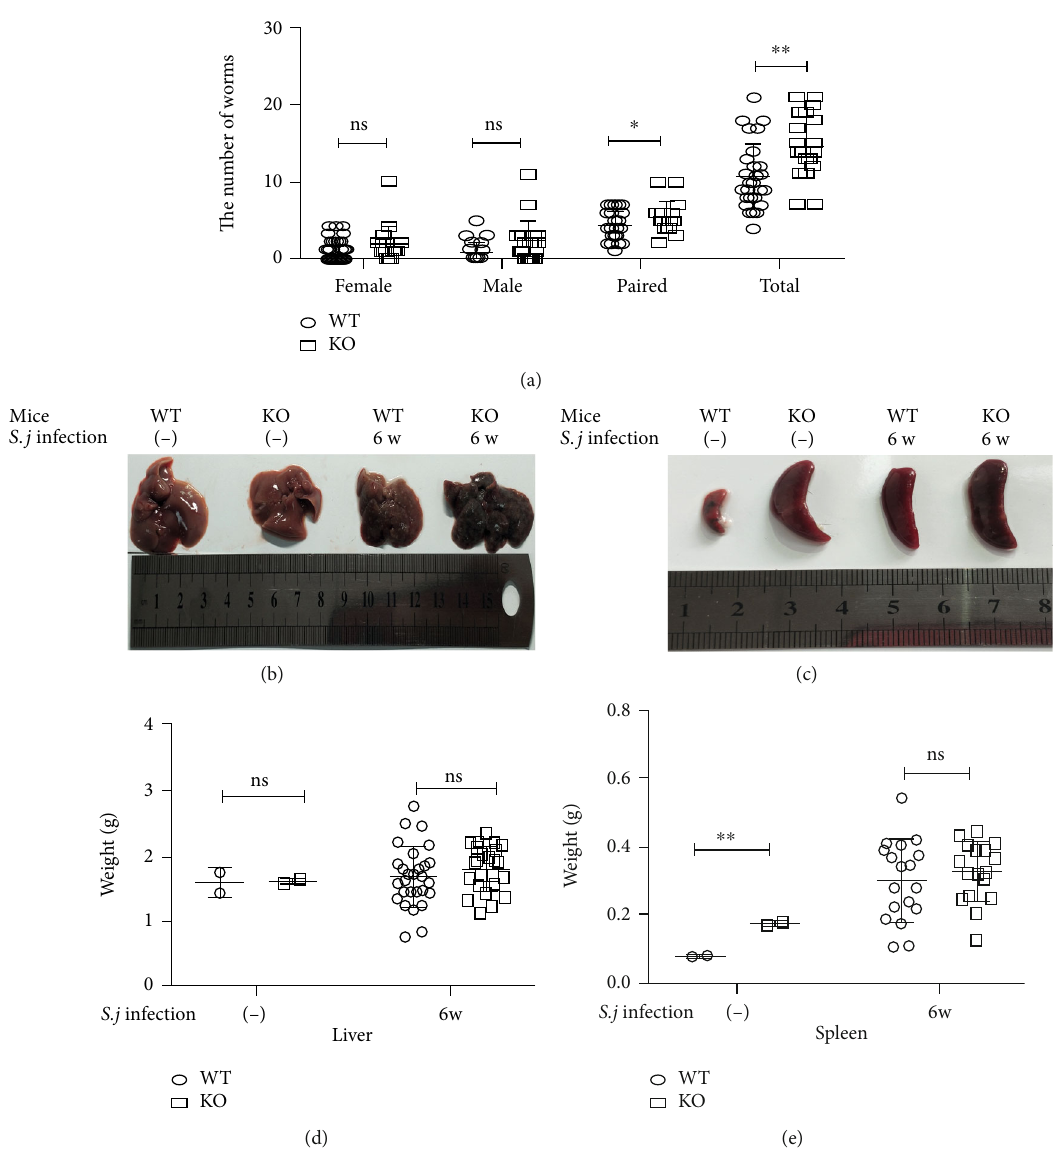
Figure 1: Deletion of USP21 in Tregs reduces the resistance to S. japonicum in infected mice. (a – e) FOXP3 Cre (WT) and USP21 fl / fl FOXP3 Cre (KO) mice ( n = 26 ± 2 /group) were infected with 25 ± 2 cercariae through the abdomen and were sacri fi ced 6 weeks after infection. The liver and spleen tissues were collected, and the adults were recovered. (a) Comparison of the number of females, males, pairs, and adults recovered from the WT- and KO-infected (INF) groups ( n = mean ± SD ), ∗ p = 0 : 01 for the total number of adults and ∗∗ p = 0 : 036 for the total number of worm pairs. (b) Representative images of the livers of the WT and KO mice from the NC and INF groups. (c) Liver weight of the WT and KO mice in the NC and INF groups ( weight = mean ± SD ); p > 0 : 05 was considered a di ff erence that was not statistically signi fi cant between the normal control group and the infected group. (d) Representative images of the spleens of the WT and KO mice in the NC and INF groups. (e) Spleen weight of the WT and KO mice in the NC and INF groups ( weight = mean ± SD ); ∗∗ p = 0 : 007 compared with the normal control group; p > 0 : 05 represented a di ff erence that was not statistically signi fi cant compared with the infected